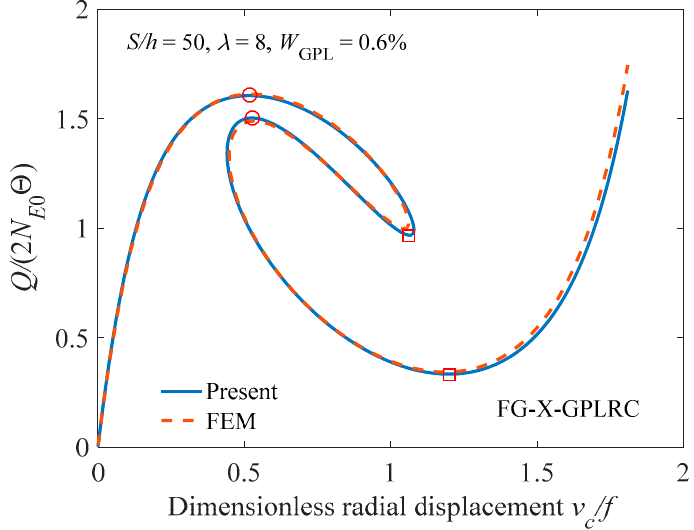
Figure 3. Comparison of analytical results and finite element results.